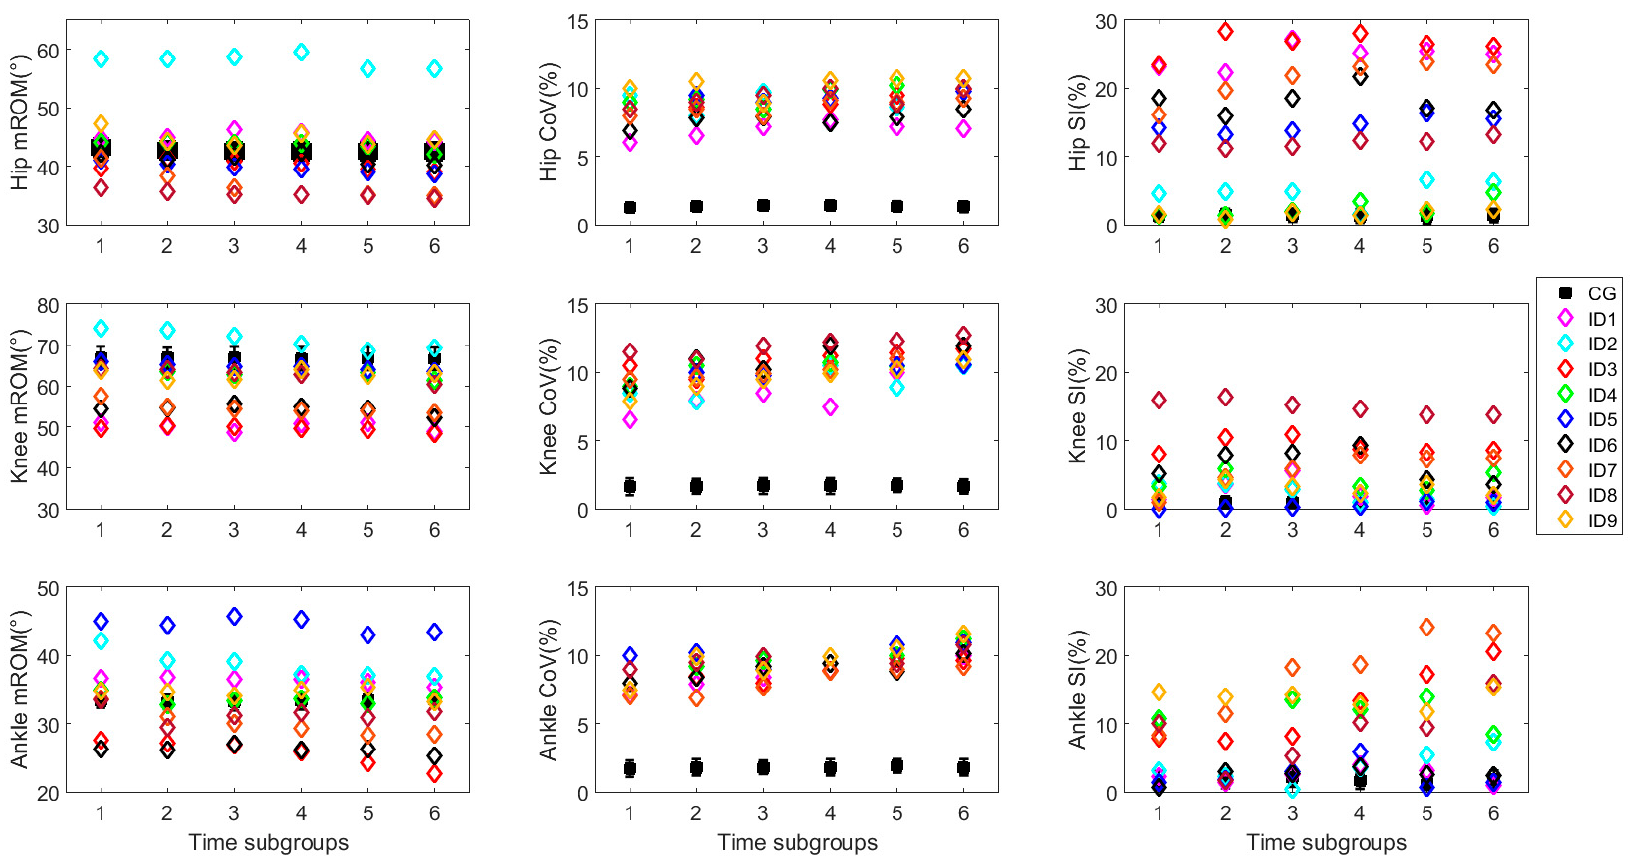
Figure 2. Evolution of mean range of motion (mROM), coefficient of variation (CoV) and symmetry index (SI) related to the six time subgroups for each joint. Black square and error bar represent mean value and standard deviation of control group. For the multiple sclerosis (MS) group, only the most variable side is reported.